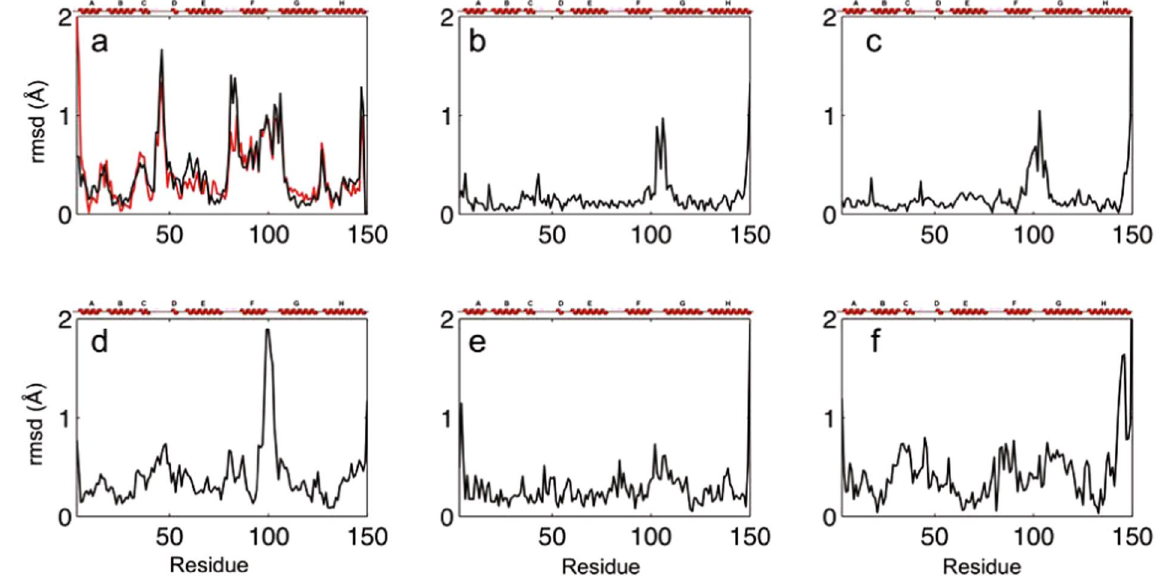
Figure 1. Root mean squares deviations calculated on the C α chain between different Ngb structures, with secondary structures shown above. ( a) Carbonmonoxy structure at 100 K (1w92) compared to ferric structure at 100 K (1q1f, in black) or to WT AP (in red). (b) V101F AP compared to WT AP. (c) F106W AP compared to WT AP. (d) WT HP-310 compared to WT AP (e) V101F-240 compared to V101F AP. (f) F106W HP-310 compared to F106W